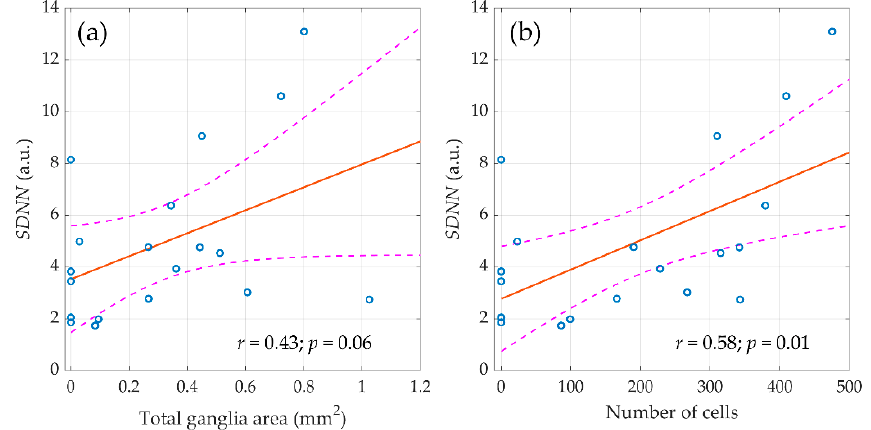
Figure 6. The linear regression between the standard deviation of normal RR intervals (SDNN), assessed three weeks after surgery and morphometric parameters of parasympathetic atrial ganglia. ( a ) Total ganglia area and ( b ) number of cells. Blue circles show the measured values, the red line is the best fit for the data, and pink dashed curves represent a 95% confidence interval for the regression line.